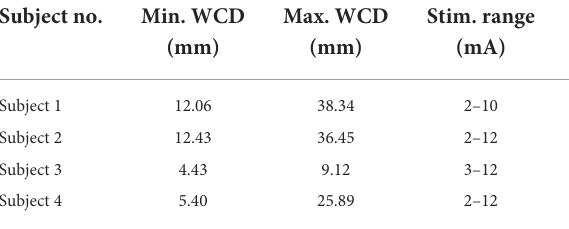
TABLE 2 WCD ranges for each subject.